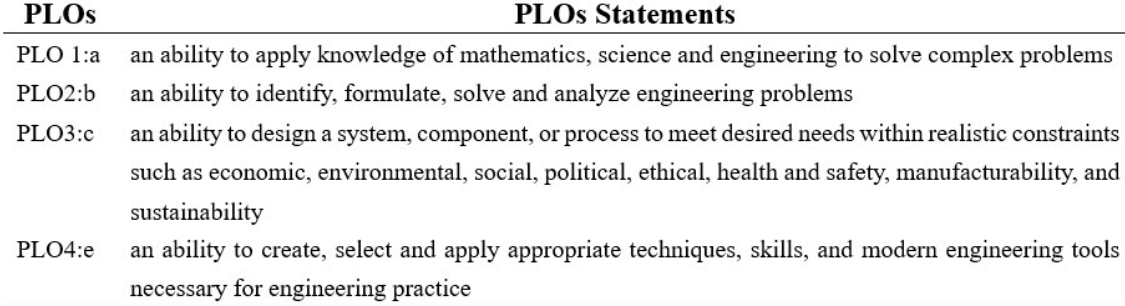
Table 2. Program learning outcomes for Metal forming and cutting